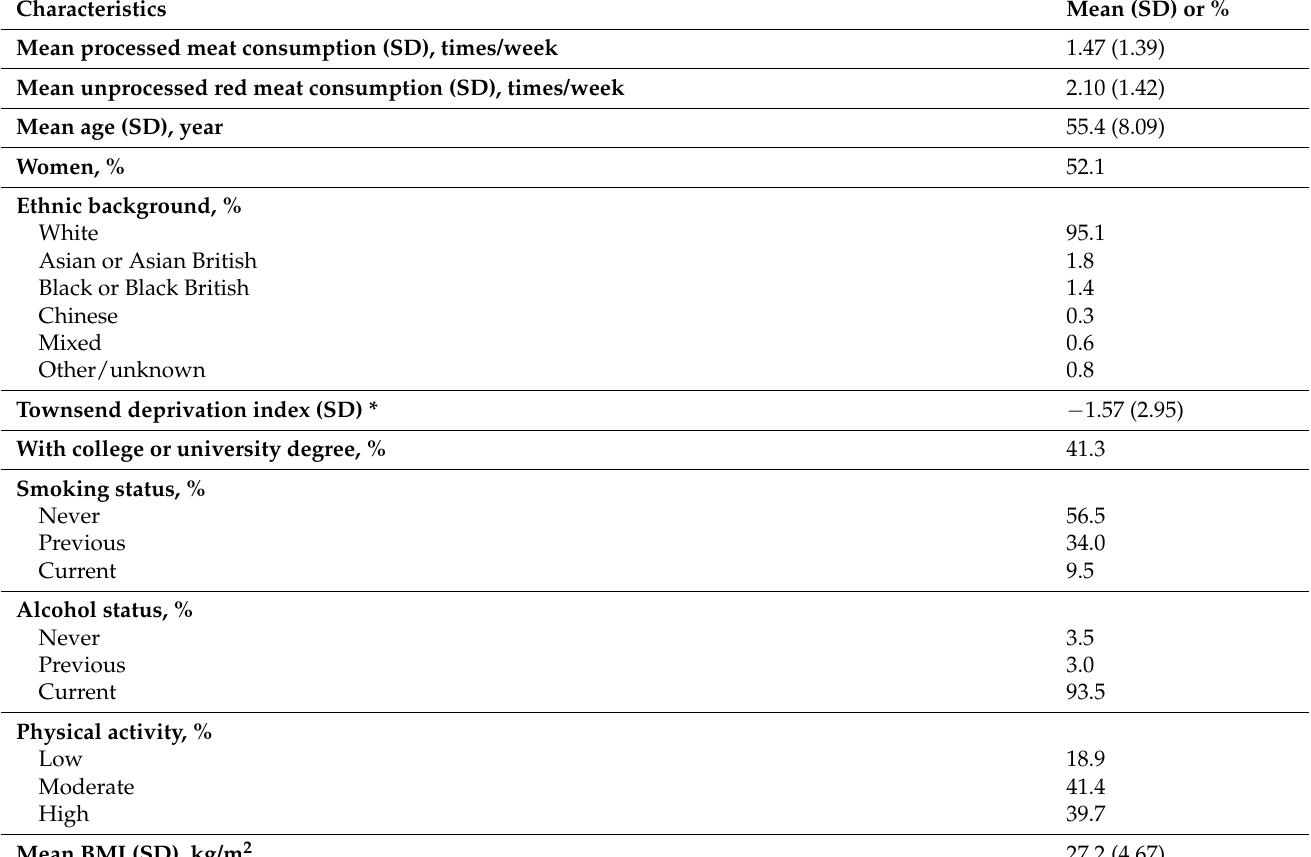
Table 1. Baseline characteristics of study